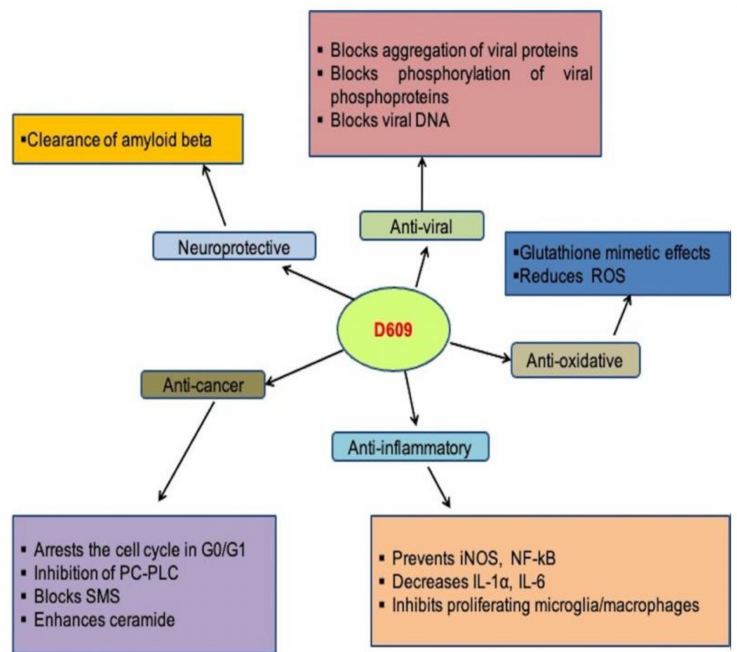
Figure 3. Role of D609 in human diseases and mechanisms